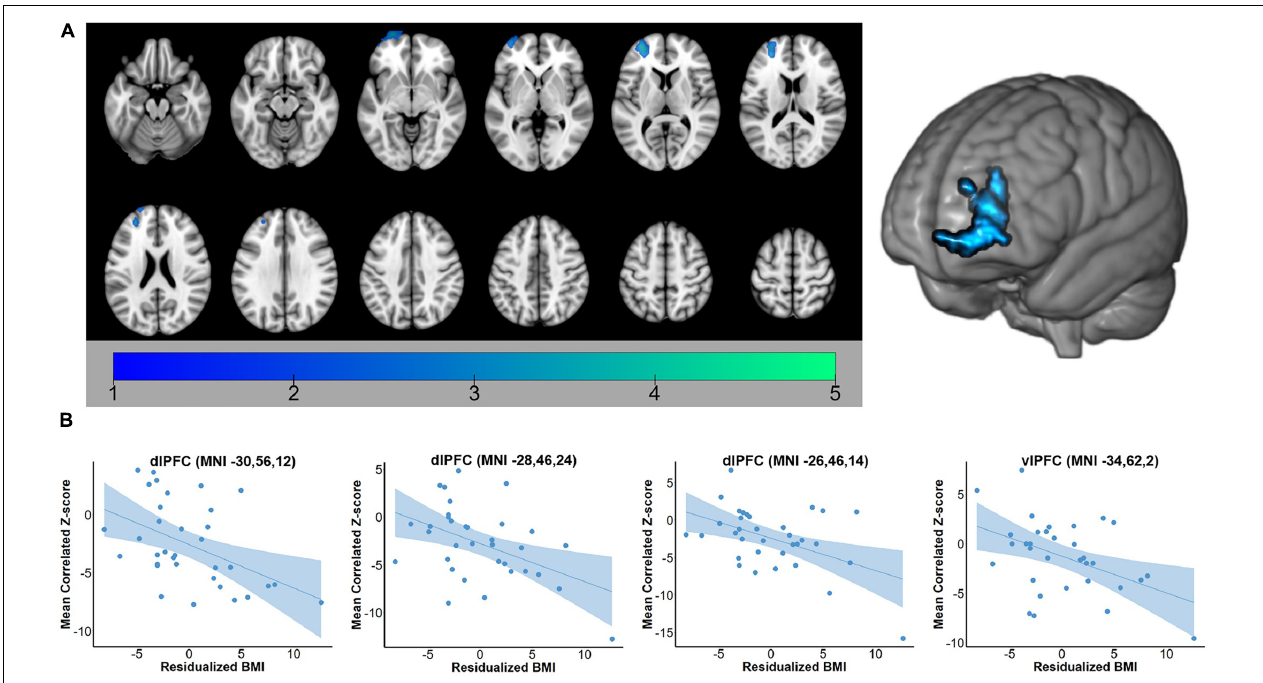
FIGURE 1 | (A) Whole-brain map of regions exhibiting negative associations between BMI and intrinsic connectivity with the hippocampus. Map was cluster thresholded at z > 2.3 and p < 0.05. (B) Scatterplots of the relationship between BMI and hippocampus-to-ROI signal covariation at rest. Note that mean framewise displacement, age, and education were regressed out of BMI values prior to plotting. BMI, body mass index; dlPFC, dorsolateral prefrontal cortex; vlPFC, ventrolateral prefrontal